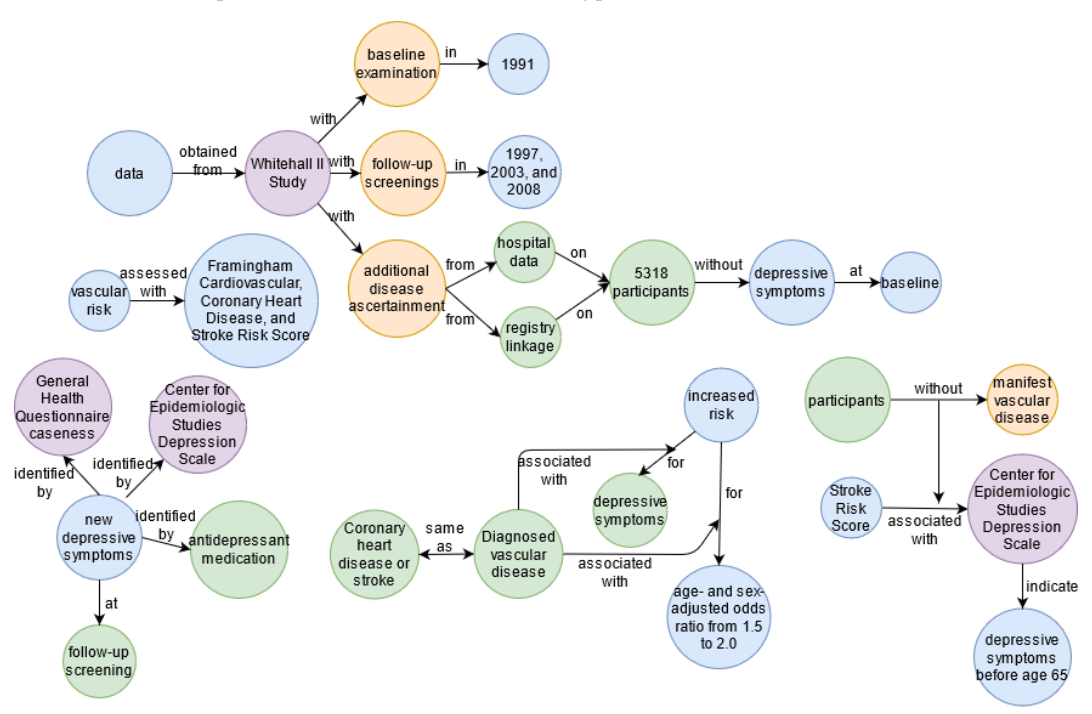
Figure A8. Structured KG representation of an Engineering domain publication Abstract [72] as process, method, material, and data typed entities.